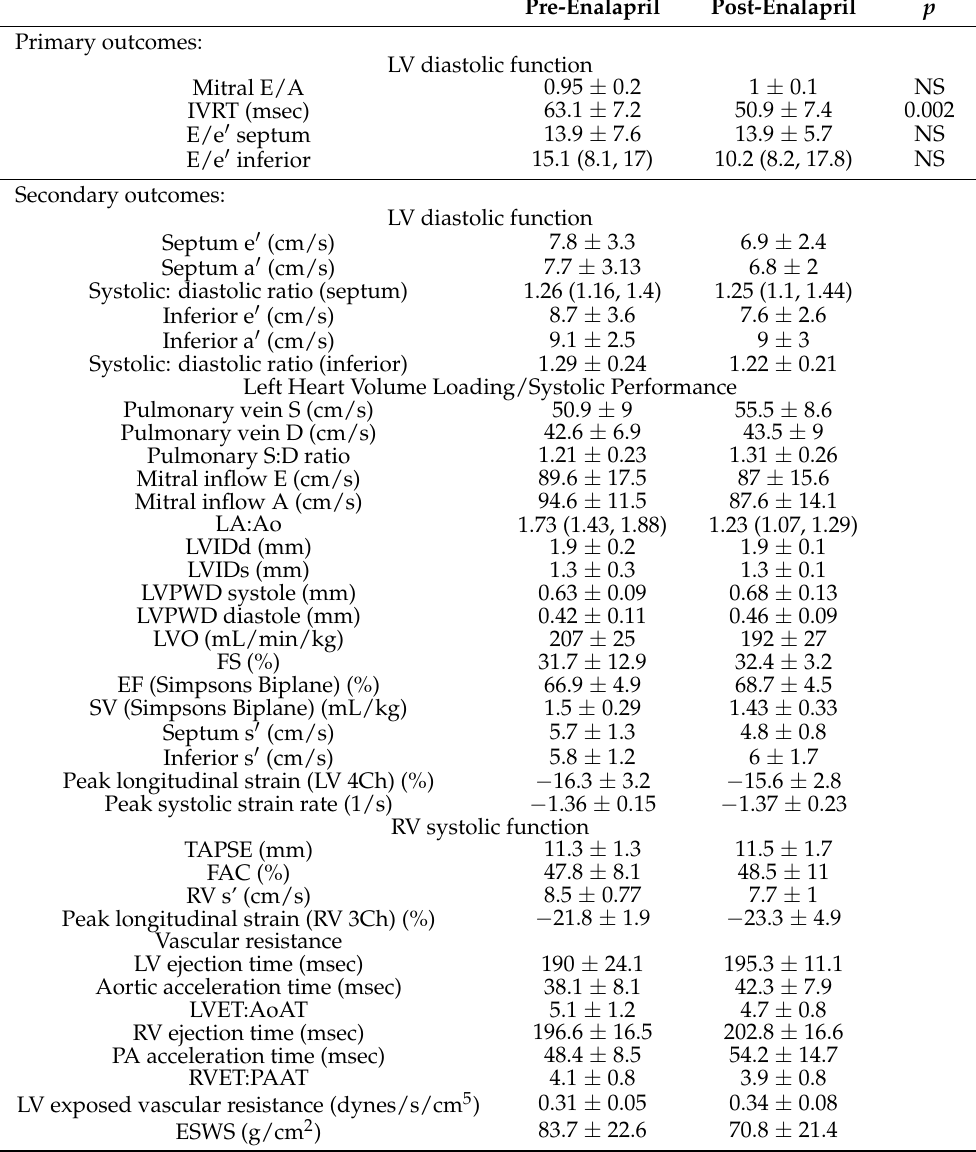
Table 2. Targeted Neonatal ECHO indices pre and post enalapril therapy in assessment prior to discharge.